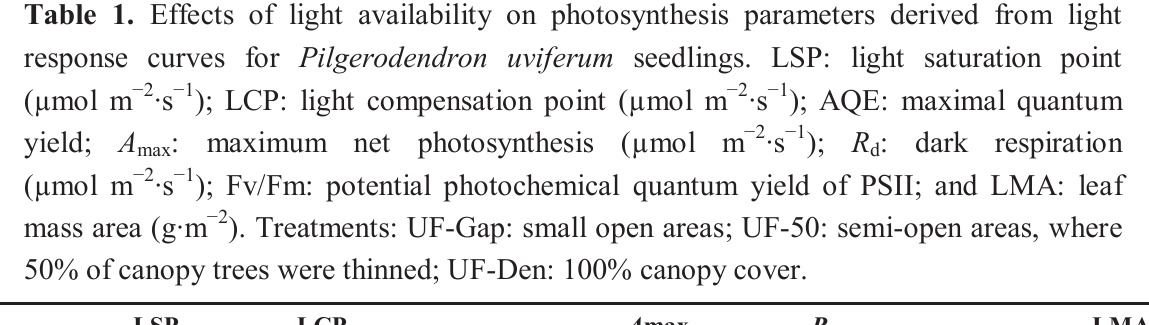
Table 1. Effects of light availability on photosynthesis parameters derived from light response curves for Pilgerodendron uviferum seedlings. LSP: light saturation